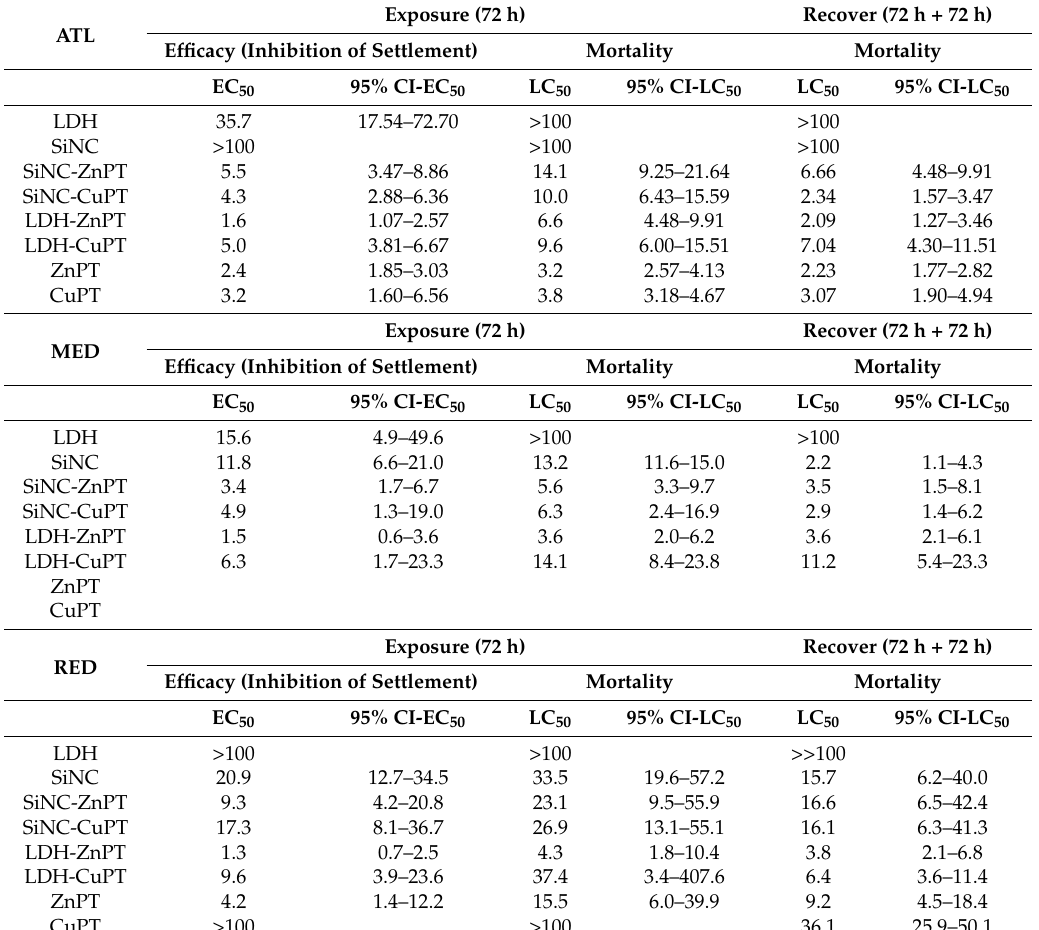
Table 2. Tested compounds and their chemical specification.